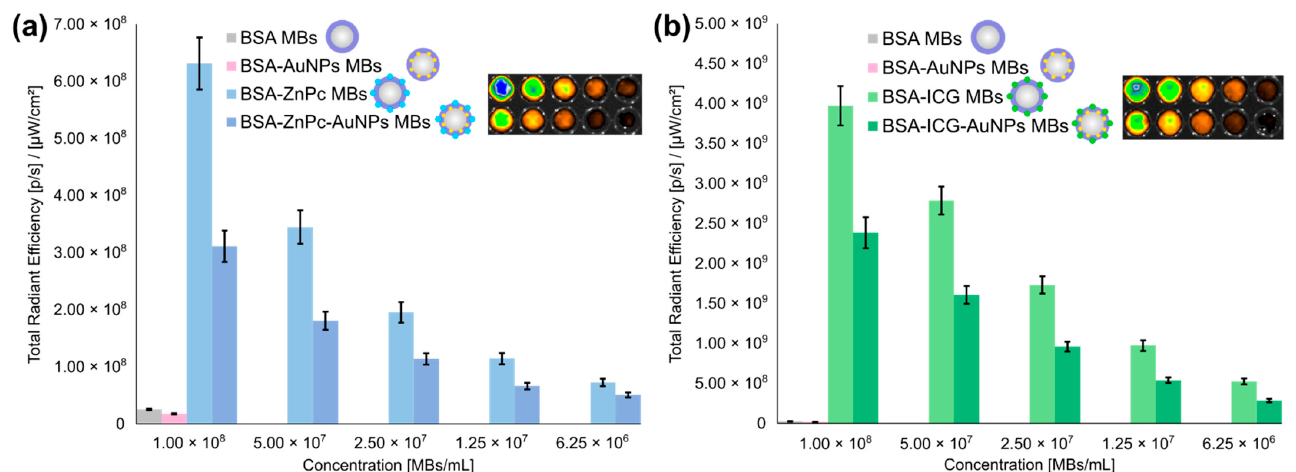
Figure 7. Fluorescence imaging of probes: comparison of total radiant efficiency dependencies on the concentration of MBs for ( a ) BSA MBs, BSA-AuNPs MBs, BSA-ZnPc MBs and BSA-ZnPc-AuNPs MBs at excitation/emission pair of 675/720 nm, ( b ) BSA MBs, BSA-AuNPs MBs, BSA-ICG MBs and BSA-ICG-AuNPs MBs at excitation/emission pair of 745/840 nm. Inlets on each figure show fluorescence imaging of a plate with BSA-ZnPc MBs, BSA-ZnPc-AuNPs MBs, and BSA-ICG MBs, BSA-ICG-AuNPs MBs solutions, respectively, in concentrations used in the plot.